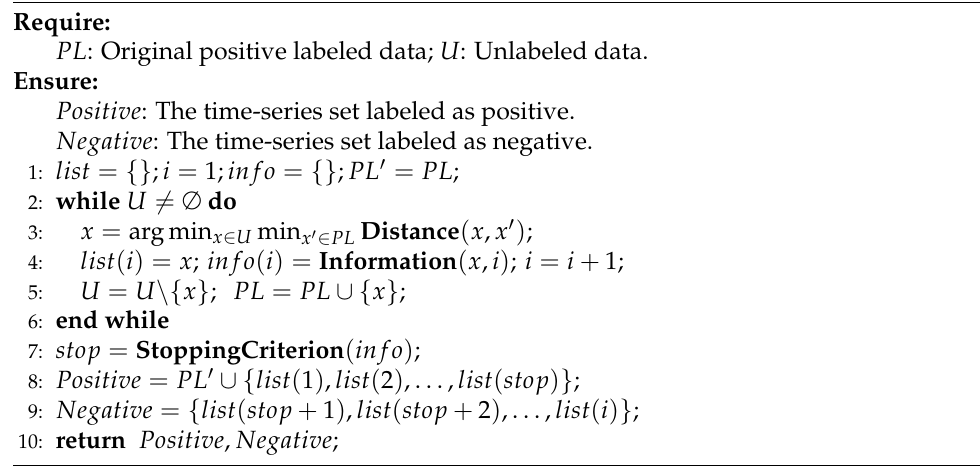
Algorithm 1 The pseudo-code of the self-training method for PUTSC